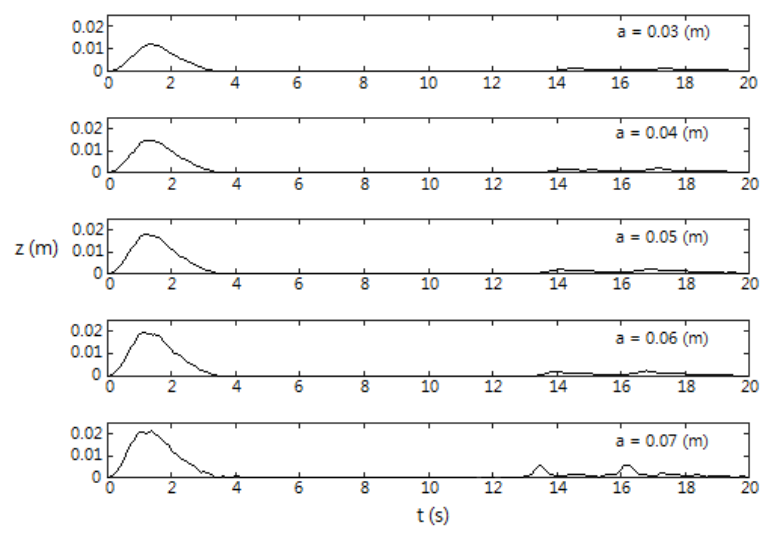
Figure 8. Free-surface elevation of leading elevation waves recorded at the hinge under different magnitudes of vertical wavemaker displacement, a . In all cases, h = 0.05 m, L = 1 m, b = 0.5 s, and θ = 0. Magnitude of vertical displacement (top to bottom): a = 0.03, 0.04, 0.05, 0.06, 0.07